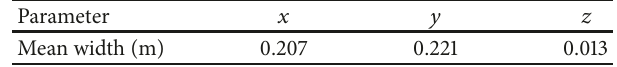
Table 1: Average bounding boxes